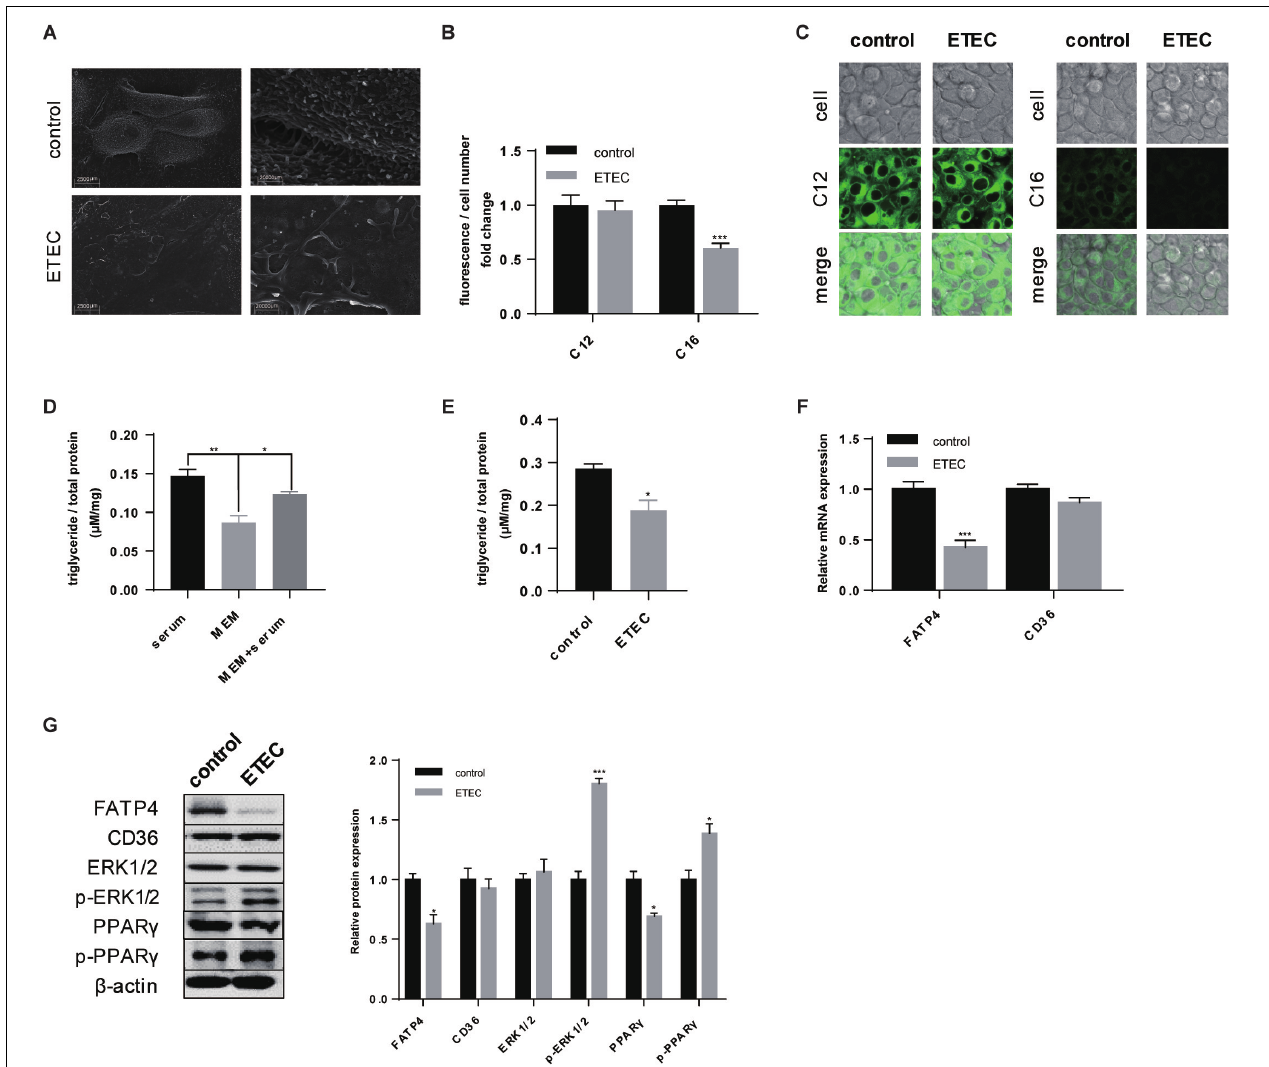
FIGURE 4 | ETEC challenge compromised LCFA uptake and initiated phosphorylation of ERK1/2 and PPAR γ . (A) SEM visualization. Scale bars, 2,500 µ m (left) and 20,000 µ m (right). (B) Uptake of Bodipy-labeled C12:0 and C16:0 normalized by cell counting. (C) Confocal microscopy of Bodipy-labeled C12:0 and C16:0 in IPEC-J2 cells. Scale bars, 10 µ m. (D) Intracellular TG accumulation measurement of consistent 3.5-h cultivation in MEM + 10% FBS (serum), 3.5-h cultivation in pure MEM (MEM), and 3-h starvation in MEM followed by 0.5-h cultivation in MEM + 10% FBS (MEM + serum). (E) The control and ETEC group were treated the same as MEM + serum whereas cells in ETEC group were firstly cultivated in ETEC-containing MEM. (F) RT-qPCR analysis of FATP4 and CD36. (G) Western-blot analysis of FA uptake associated proteins FATP4 and CD36; signaling pathway proteins ERK1/2, p-ERK1/2, PPAR γ , p-PPAR γ . Data are presented as mean ± standard error. ∗ P < 0.05, ∗∗ P < 0.01, and ∗∗∗ P < 0.001.